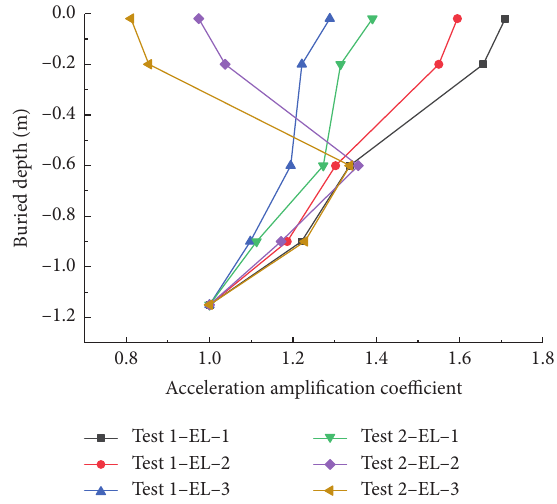
Figure 8: Case 1 acceleration amplification factor of soil layer.